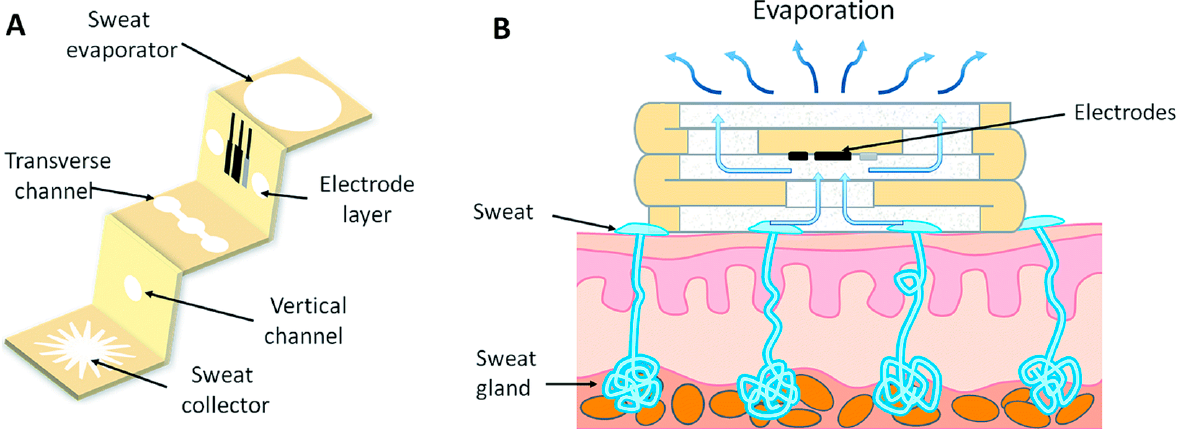
Figure 2. Schematic diagram of the three-dimensional paper-based microfluidic electrochemical integrated device. ( A ) The layered structure of the device. 3D-PMED includes the sweat collector, vertical channel, transverse channel, electrode layer, and sweat evaporator. The yellow areas or the white areas on the device were hydrophobic areas formed by wax screen-printing or hydrophilic areas of filter paper, respectively. A three-electrode electrochemical sensor created by screen-printing was affixed on the electrode layer of the device using double-sided adhesive tape. ( B ) The schematic diagram of the 3D-PMED applied on the skin of a human. A 3D-flow channel was formed by folding the device with the tiered structure to help the sweat to flow from the skin into the device and thus refresh the sweat under the electrodes. Reproduced with permission from Ref. [33], Copyright 2019, RSC.